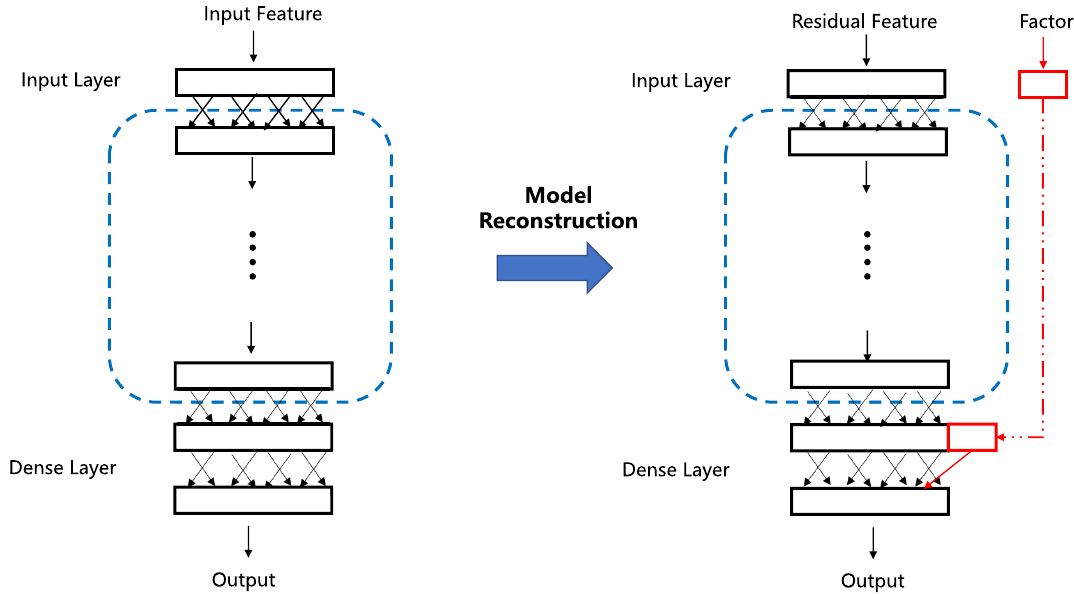
Figure 1. Graphic illustration of model reconstruction for factor normalization. The rectangles represent the DNN feature maps. The blue dashed rectangle represents the latent layers between the input and the last dense layer. The left panel shows the original DNN structure with the original input feature. The right panel shows the modified DNN structure with factor and residual features. As can be seen, the factor and residual features are treated separately. The latent factor is reinserted back into the model before the last dense output